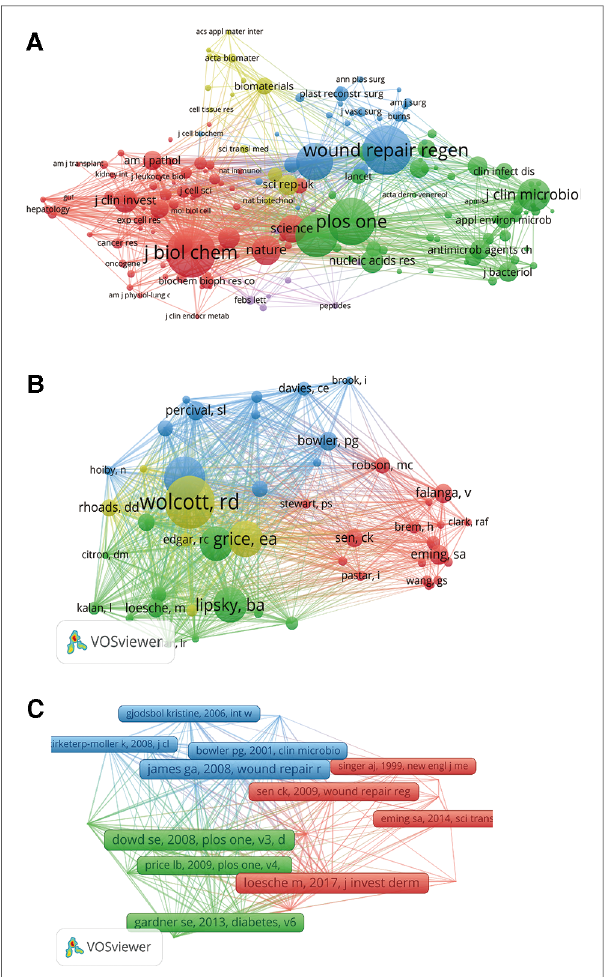
FIGURE 5 Mapping of co-citation analysis of HTS technology associated with chronic wounds. ( A ) Mapping of the 172 identi fi ed journals. ( B ) Mapping of the 48 identi fi ed authors. ( C ) Mapping of the 25 identi fi ed